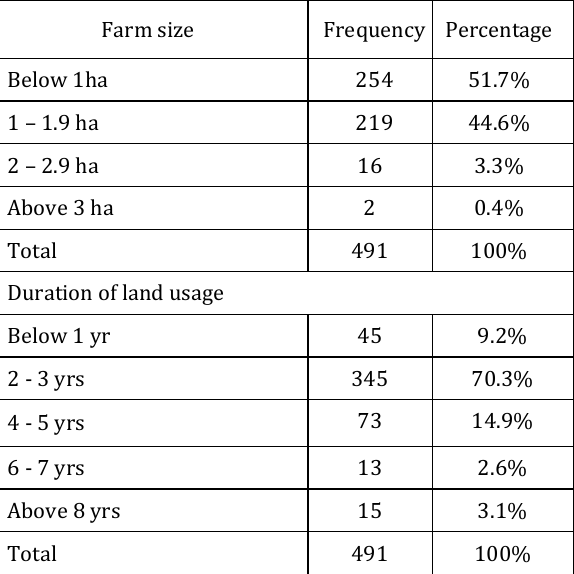
Table 3. Farm size and duration of land